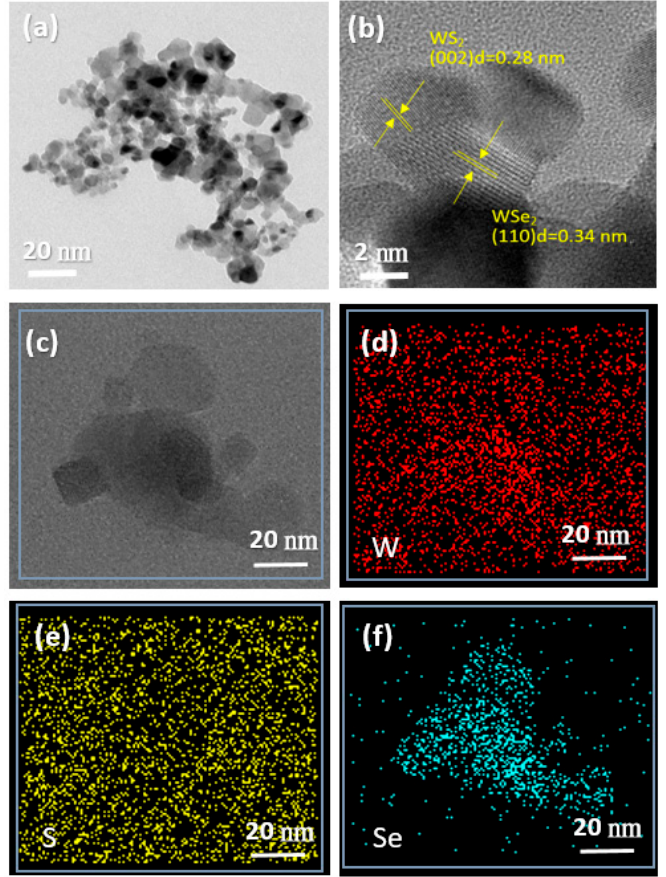
Figure 3. TEM images of ( a ) WSSe-3; HRTEM images ( b ) and element mapping images ( c – f ) of WSSe-3.